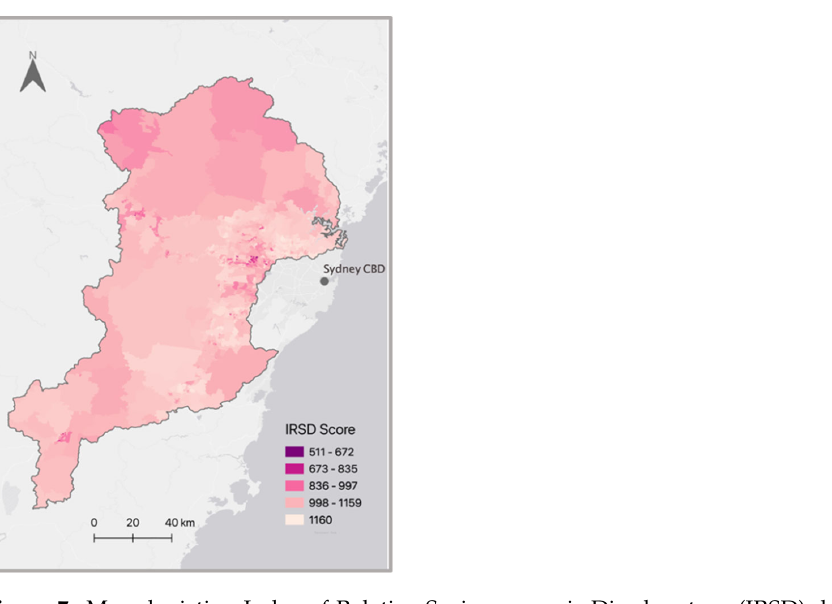
Remote Sens. 2022 , 14 , x FOR PEER REVIEW